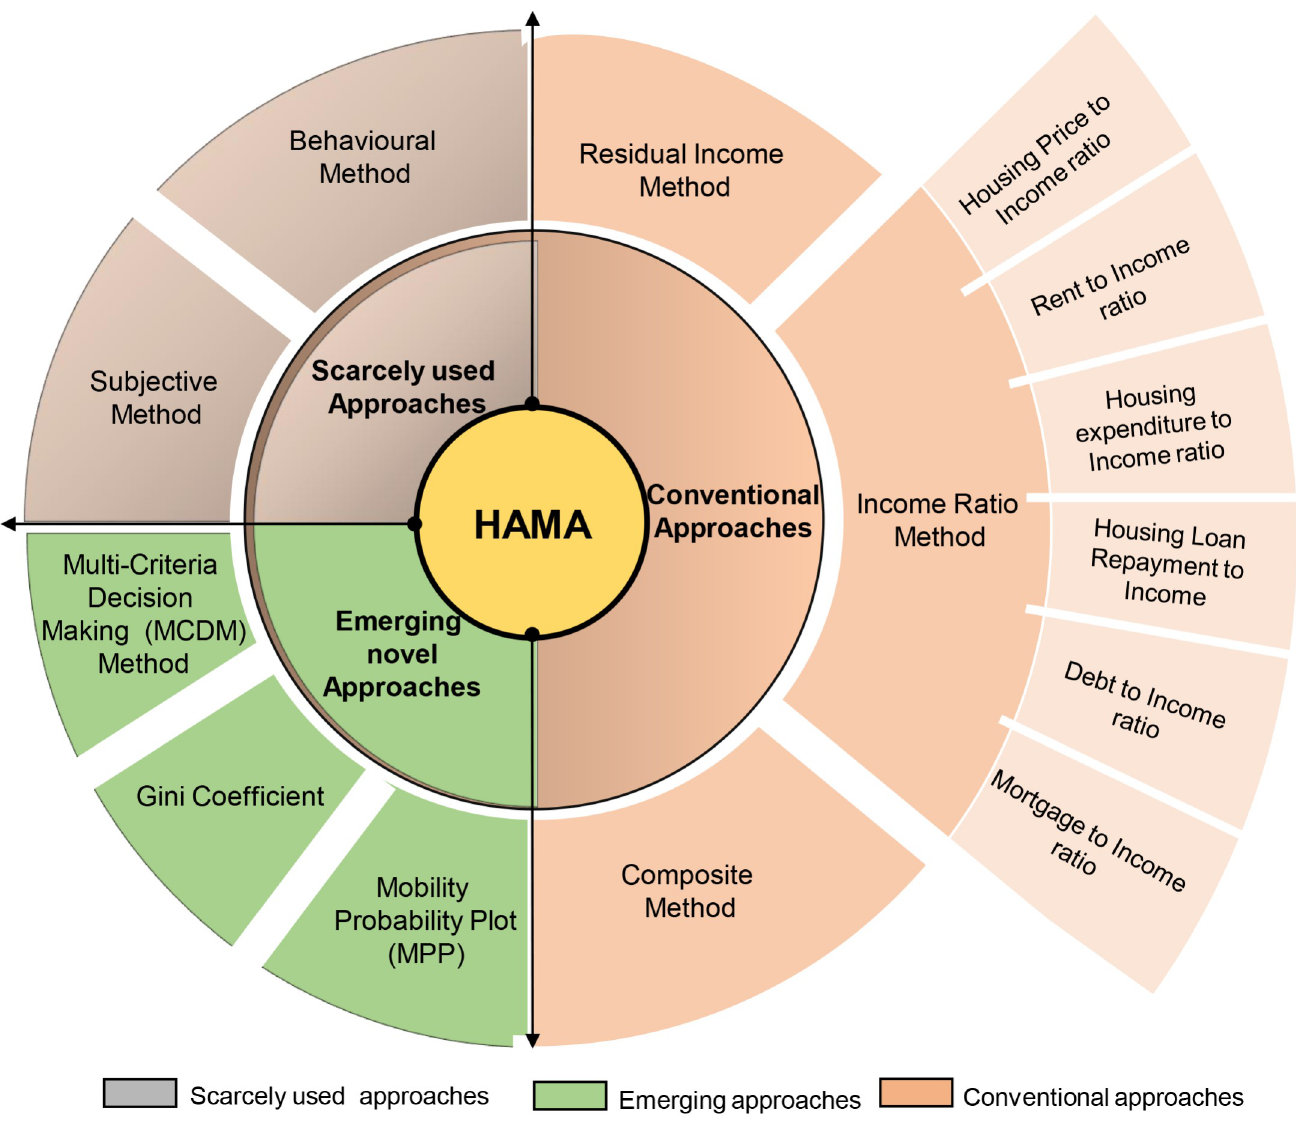
Fig 3. Classification of HAMA based on literature survey.